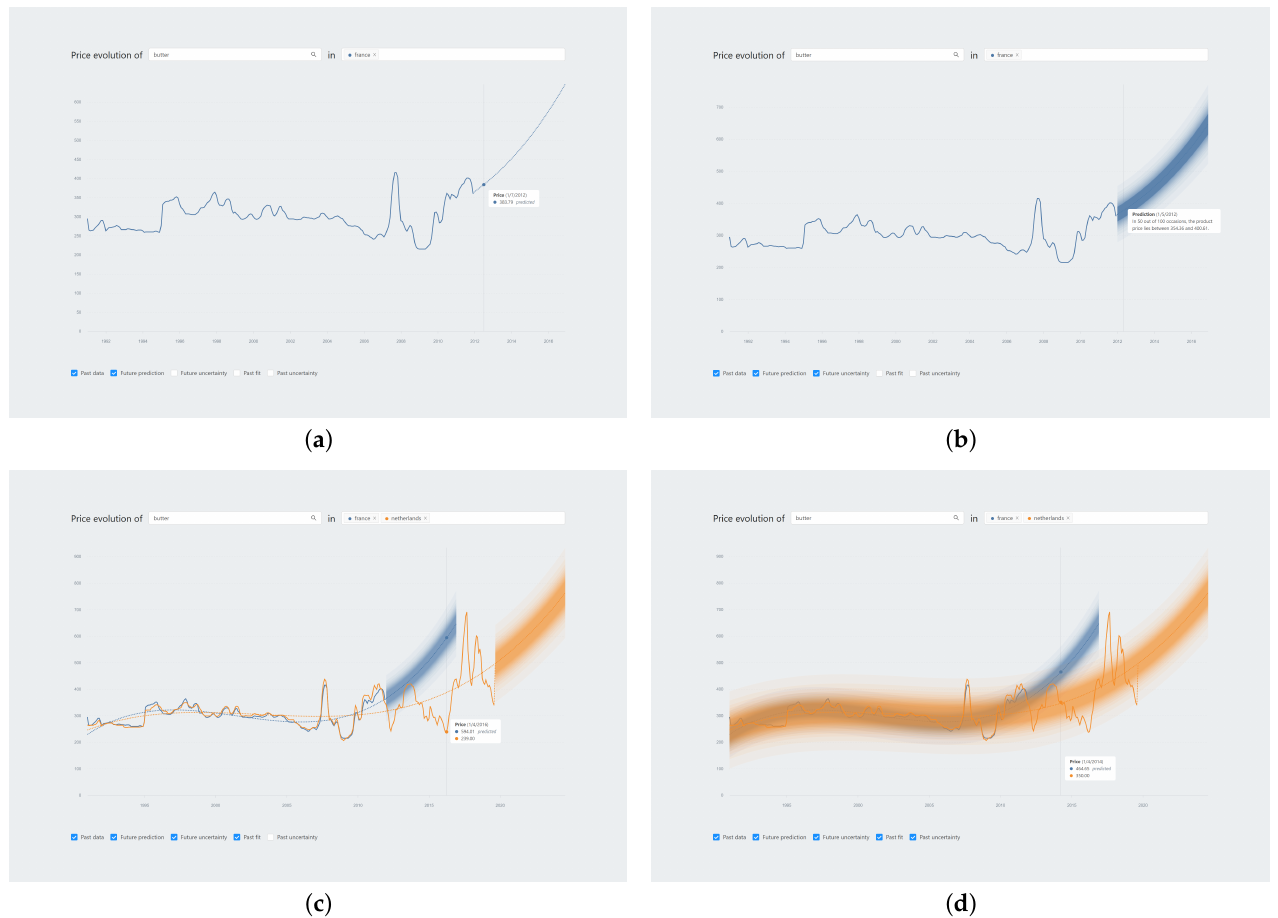
Figure 3. Our visual DSS with different sets of enabled visual components. ( a ) Scenario 1: the future prediction for France is visualised as a dashed line. ( b ) Scenario 2: the future uncertainty for France is visualised as fans. ( c ) Scenario 7: the past fit for France and the Netherlands is visualised as dashed lines. ( d ) Scenario 8: the past uncertainty for France and the Netherlands is visualised as